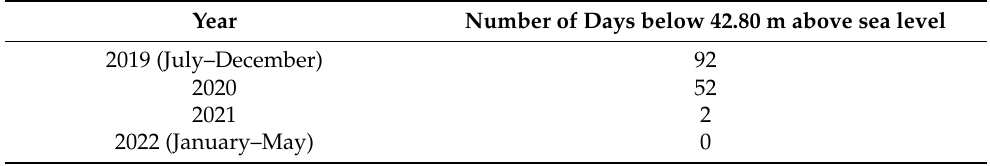
Table 3. Water ordinate in the lower avantport of the Włocławek